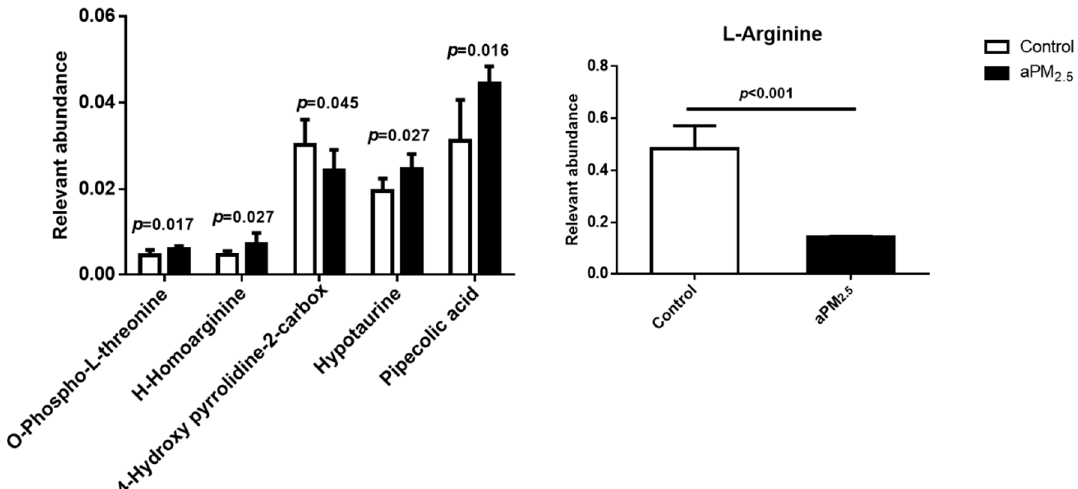
Figure 5. The discriminating metabolites obtained from lung tissue samples in the control and aPM 2.5 groups by LC-MS/MS analysis. Data were calculated from the ratio of the mean peak areas in the control and aPM 2.5 groups and normalized to L-norvaline (internal standard); p value of independent t -test, n = 8.